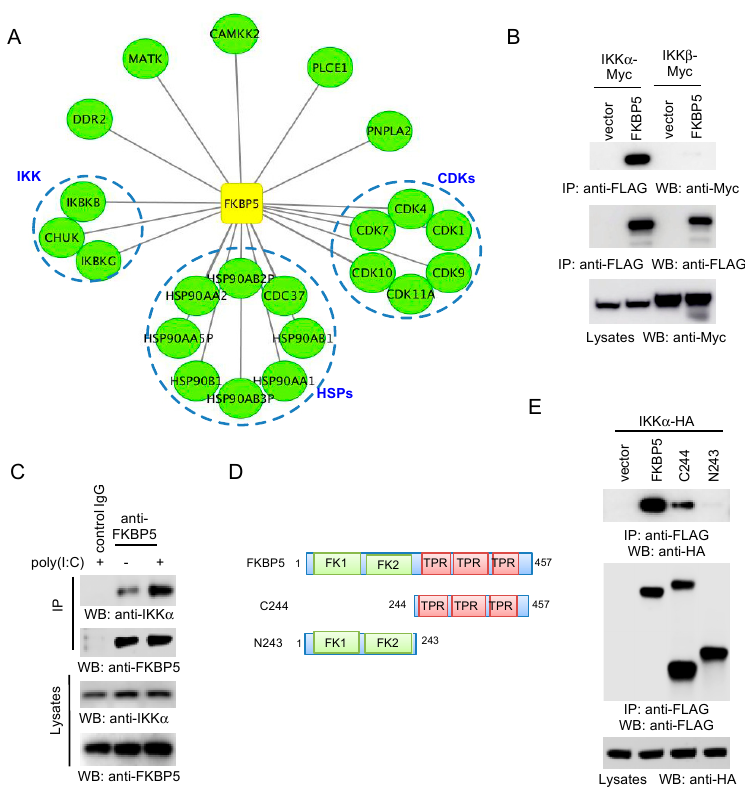
Figure 3. FKBP5 interacts with IKK α . ( A ) Map of the FKBP5 protein interaction network. FKBP5 and the high confidence candidate interacting proteins (HCIPs) are shown as square and circles, respectively. ( B ) Vector or FLAG-tagged FKBP5 was co-transfected with Myc-tagged IKK α or IKK β into HEK293 cells. After 48 h, cell lysates were immunoprecipitated and blotted as indicated. ( C ) HEK 293 cells were stimulated with 1 µg/mL poly(I:C) for 4 h. Cell lysates were immunoprecipitated and blotted as indicated. The same isotype Immunoglobulin G (IgG) was used as a control for immunoprecipitation (IP). ( D ) Schematics of the FKBP5 mutants. FK stands for FKBP; TPR stands for tetratricopeptide repeats. ( E ) Hemagglutinin (HA)-tagged IKK α was transfected with the pCMV-3Tag-8 vector, FLAG-tagged FKBP5, or the indicated FLAG-tagged FKBP5 mutant. After 48 h, the cell lysates were immunoprecipitated and blotted as indicated.